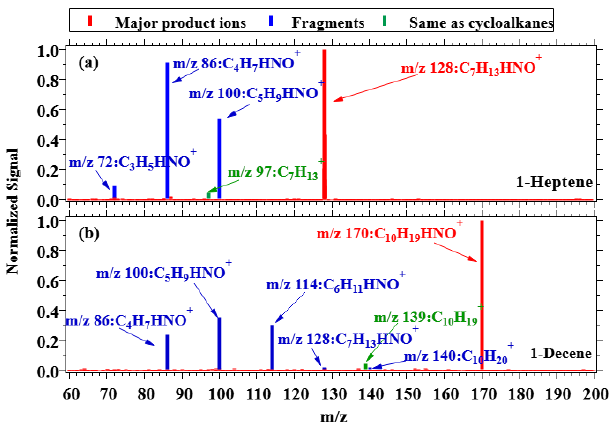
Figure 3. Mass spectra of product ions from 1-heptene (a) and 1- decene (b) with NO + PTR-ToF-MS. The major product ions are shown in red. The same product ions as the cycloalkanes (M–H ions) are shown in green, and other fragments are shown in